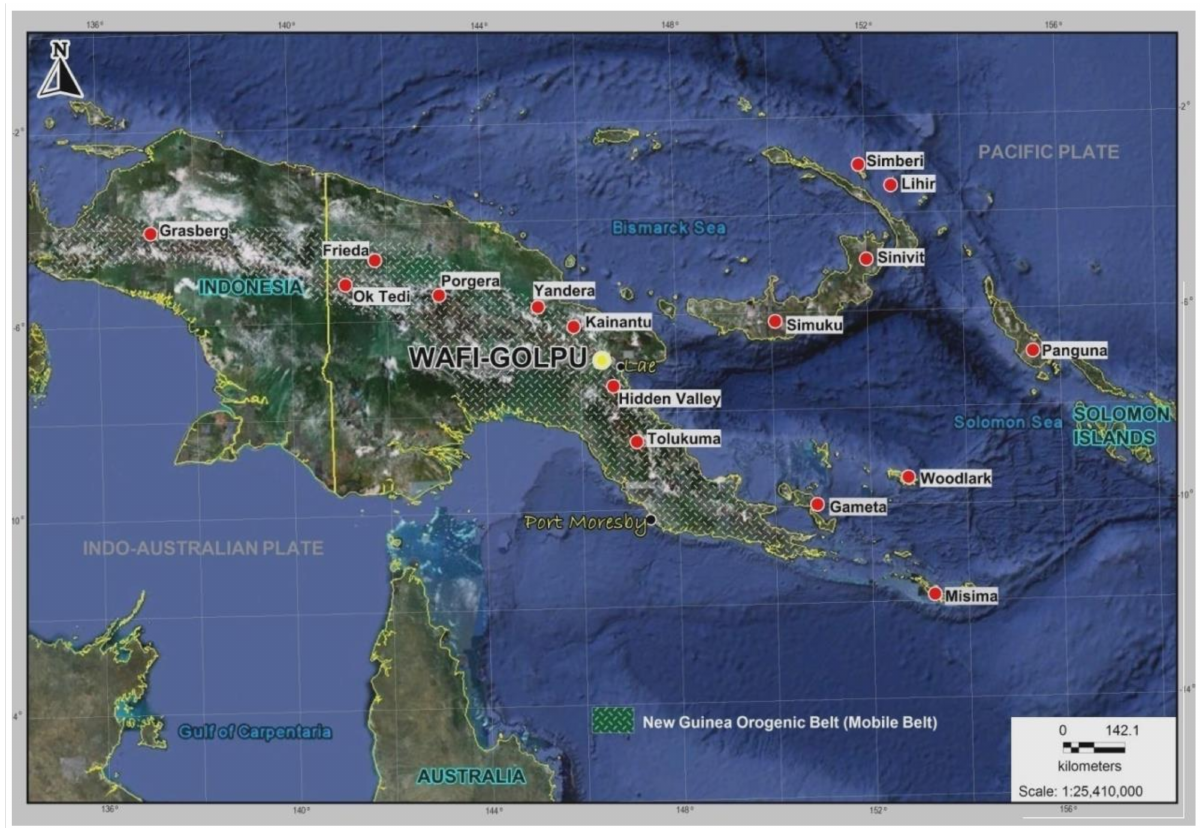
Figure 1. Location of some intrusion-related Cu and Au deposits in Papua New Guinea. The WGMD, represented by the Wafi-Golpu mineralized systems, is located west-southwest of Lae and north-northwest of the Hidden Valley